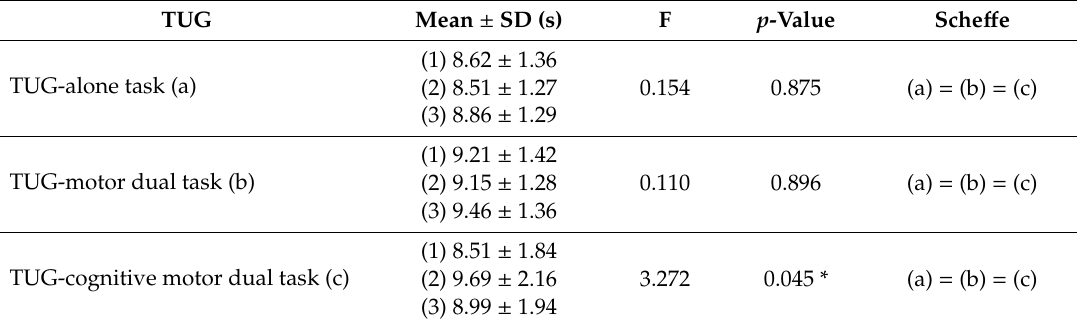
Table 2. Mean di ff erence of 3 types TUG tasks by impulsiveness total score. TUG Mean ± SD (s) F p -Value Sche ff e